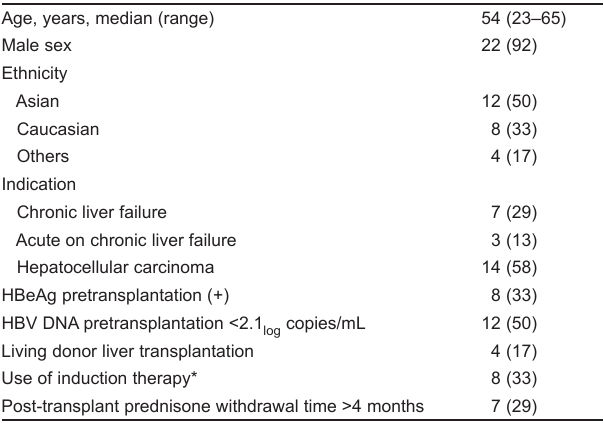
Table 1 Patient characteristics Age, years, median